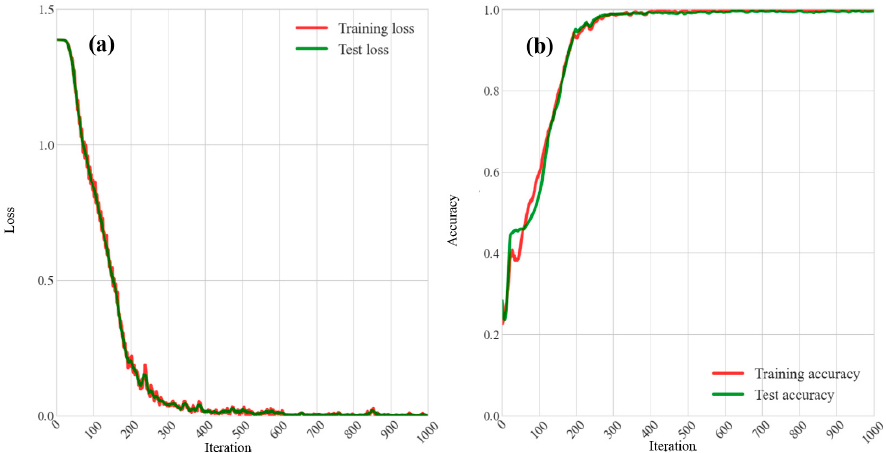
Figure 13. The loss ( a ) and accuracy ( b ) of MFAGNet with the new dataset by using combination A during the training